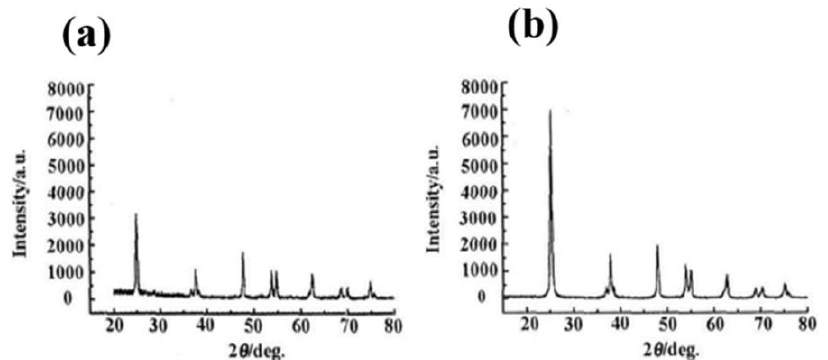
Figure 2. The XRD patterns of TiO 2 -bulk ( a ) and TiO 2 -rod ( b ).